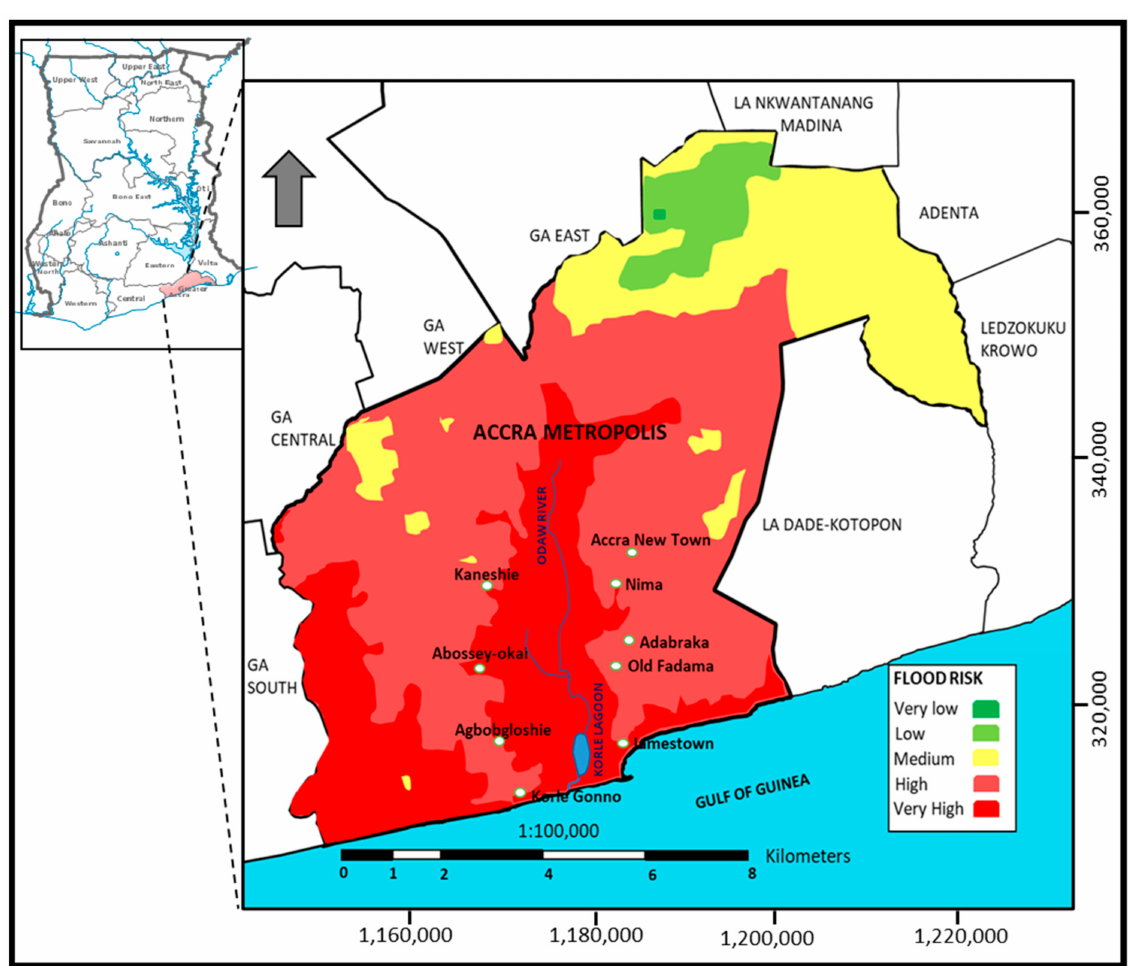
Figure 3. Flood risk map of Accra Metropolis indicating selected